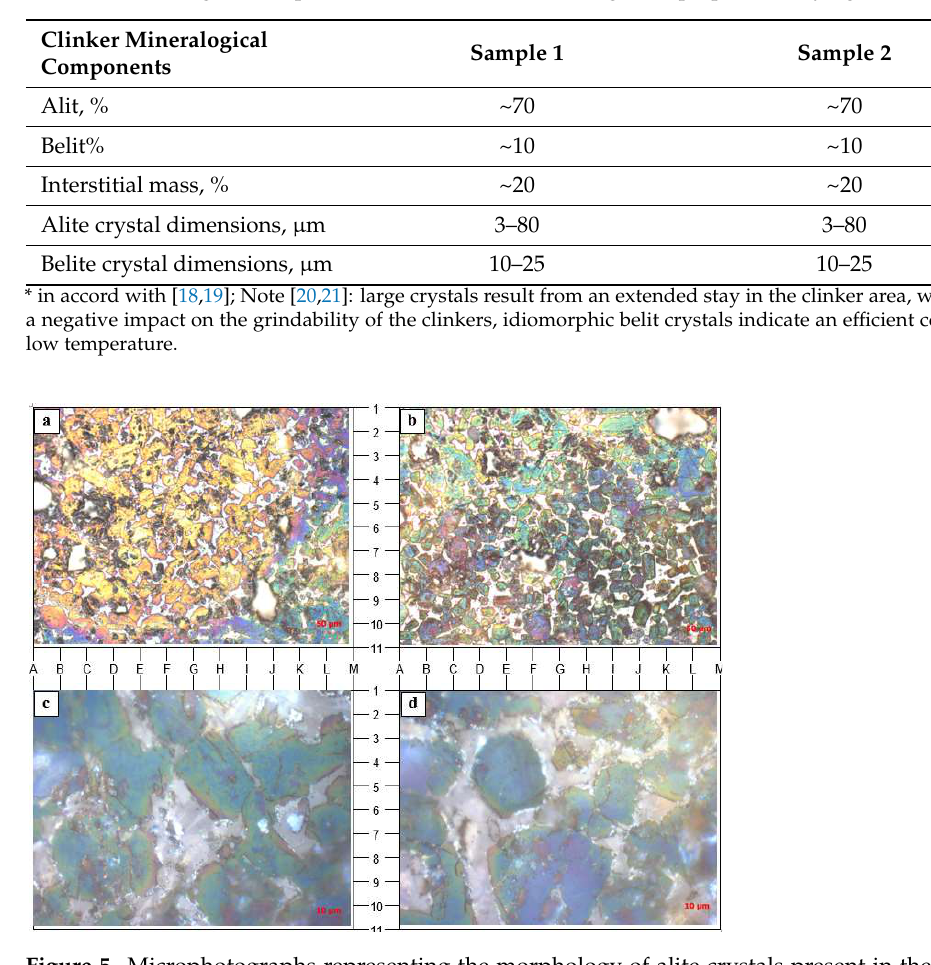
Table 3. Mineralogical composition of the clinker * resulting from preparation by light microscopy.